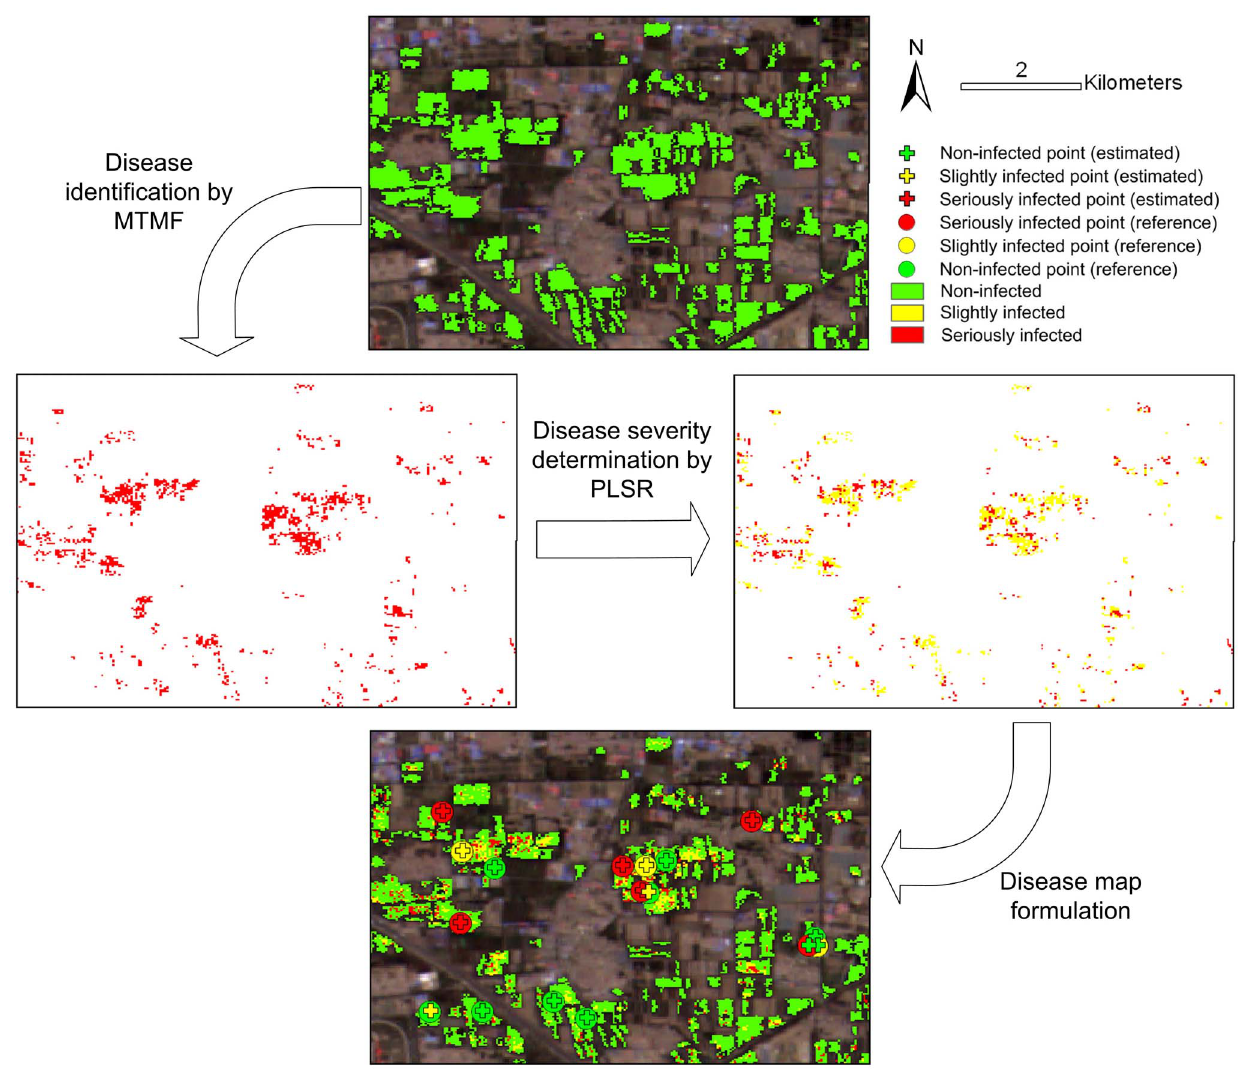
Figure 10. Workflow of an integration of MTMF and PLSR in mapping powdery mildew.